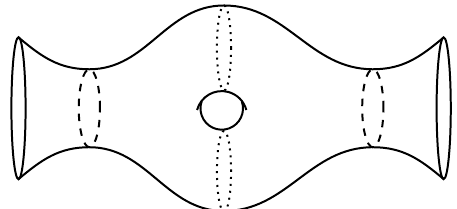
Figure 12. A Cauchy slice of the (2 , 1) geometry showing the horizons (dashed lines) and the two extremal surfaces (dotted lines) in the causal shadow region. In the hot limit, the length of both types of surfaces have to be taken to be large so that, by the Gauss-Bonnet theorem, there will be a large region where they are arbitrarily close to each